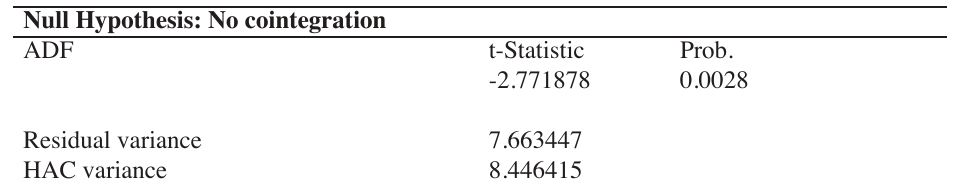
Table 4. Kao Residual Co-integration